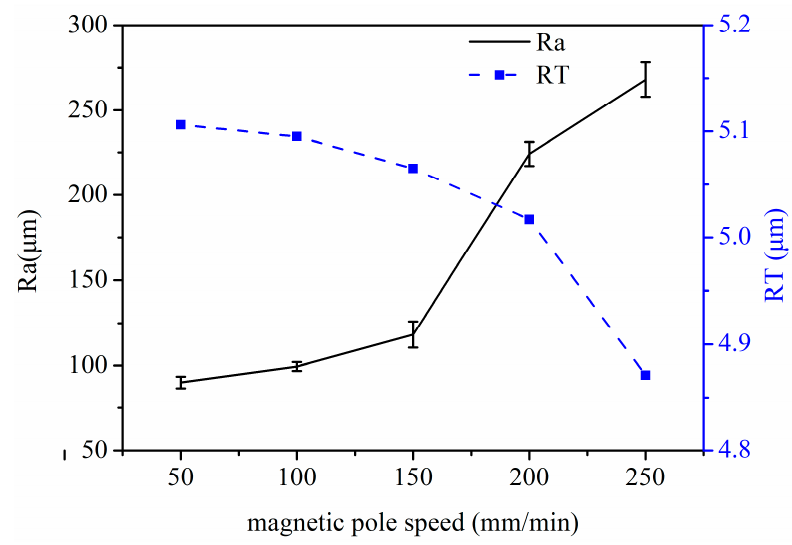
Figure 9. Graph of the effect of magnetic pole speed on Ra and RT values.